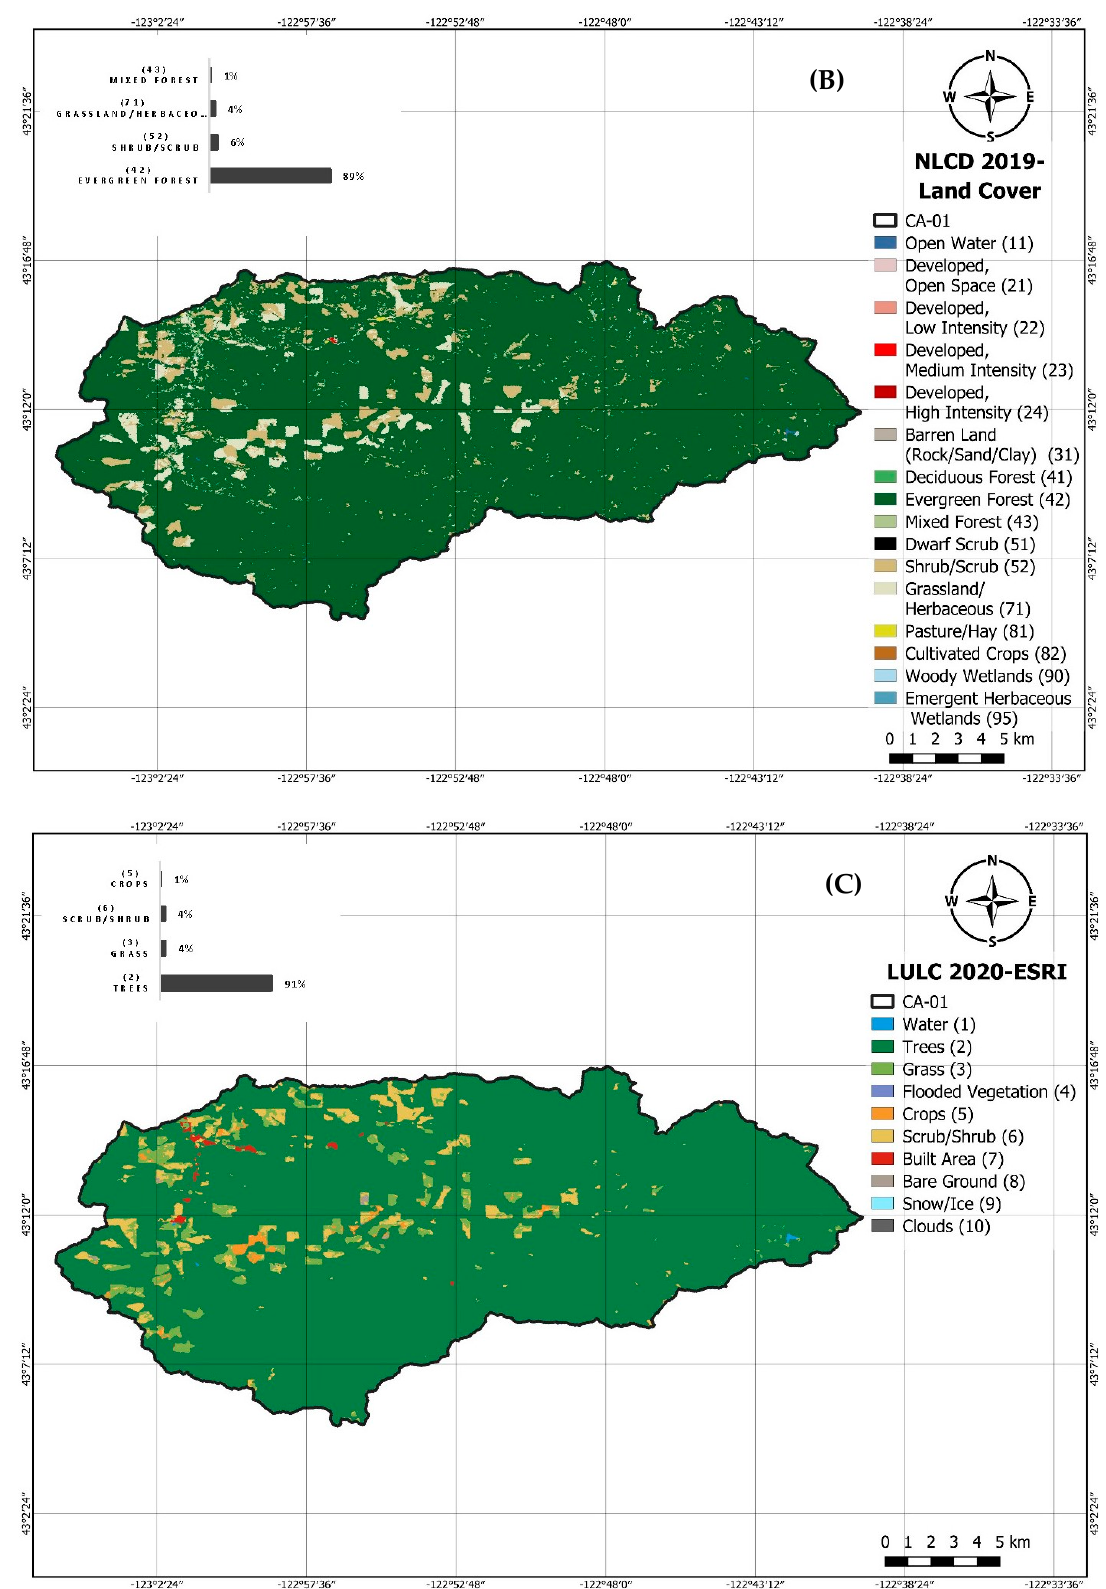
Figure A1 . DEM and land-use maps for Catchment CA-01 ( A ) DEM, ( B ) NLCD 2019 land-use map, ( C ) LULC 2020-ESRI land-use map.